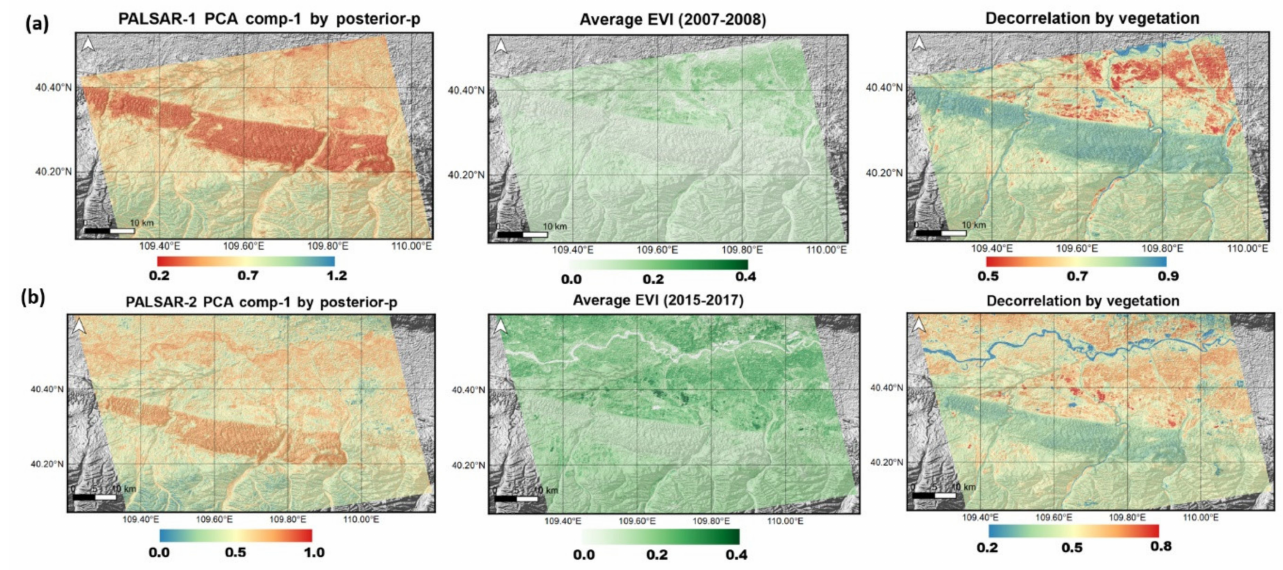
Figure 6. ( a ) Pre-decomposition stage in PALSAR-1 (2007–2008 period) by a posterior processor. ( b ) Pre-decomposition stage in PALSAR-2 (2015–2017 period) by a posterior processor with LANDSAT-8 EVI average. The left is the PCA component 1 of PALSAR-1/2 phase coherence, the middle corresponds to the LANDSAT-5/8 EVI average over the InSAR observation time period, and the right is the simulated decorrelation map by vegetation decorrelation model and the EVI map.